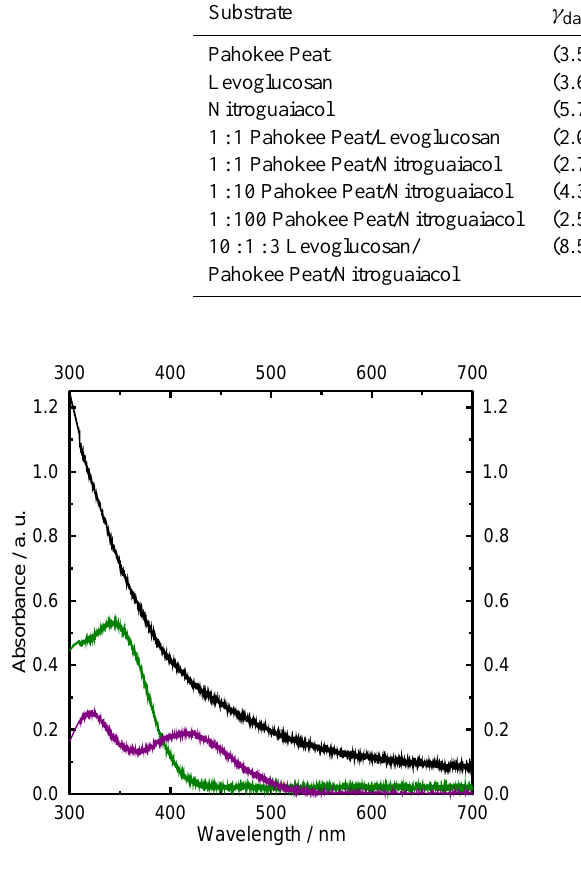
Fig. 5. Comparison of relative absorbances as a function of wave- length. Aqueous Pahokee peat, centrifuged to remove particulate matter, is shown in black, and 5-nitroguaiacol in a 0.01M HCl so- lution (pH = 2) and a 0.01M NaOH solution (pH = 12) are shown in green and purple, respectively.